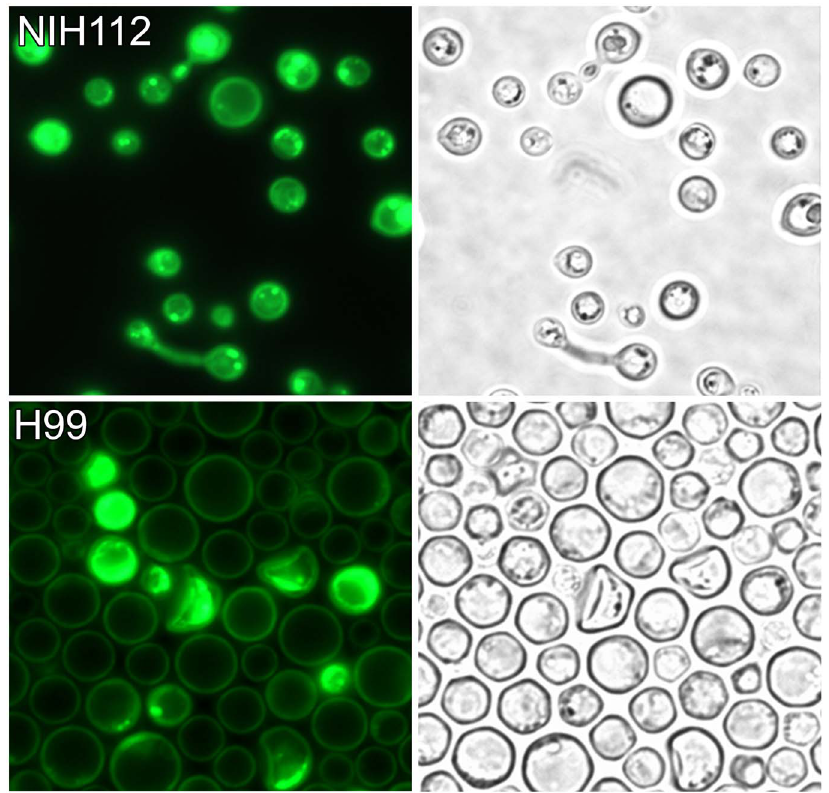
Figure 3. Visible and fluorescent microscopy of Cryptococcus. Visible and fluorescent microscopy (FITC filter) of C. gattii, NIH 112, (top) and C. neoformans var. grubii, H99, (bottom). The majority of the yeast cells have a normal appearance but atypical morphology was occasionally observed after growth on tryptophan. C. gattii and C. neoformans var. grubii cells exhibit strong fluorescence with the FITC filter. C. gattii cells often contained small concentrated foci that were fluorescent. The cell walls of C. neoformans var. grubii were usually fluorescent. The strains of C. neoformans var. neoformans which produced brown pigments exhibited a fluorescent pattern that resembled C. gattii whereas the strains that produced the pink pigment had a fluorescent pattern that was similar to C. neoformans var. grubii.